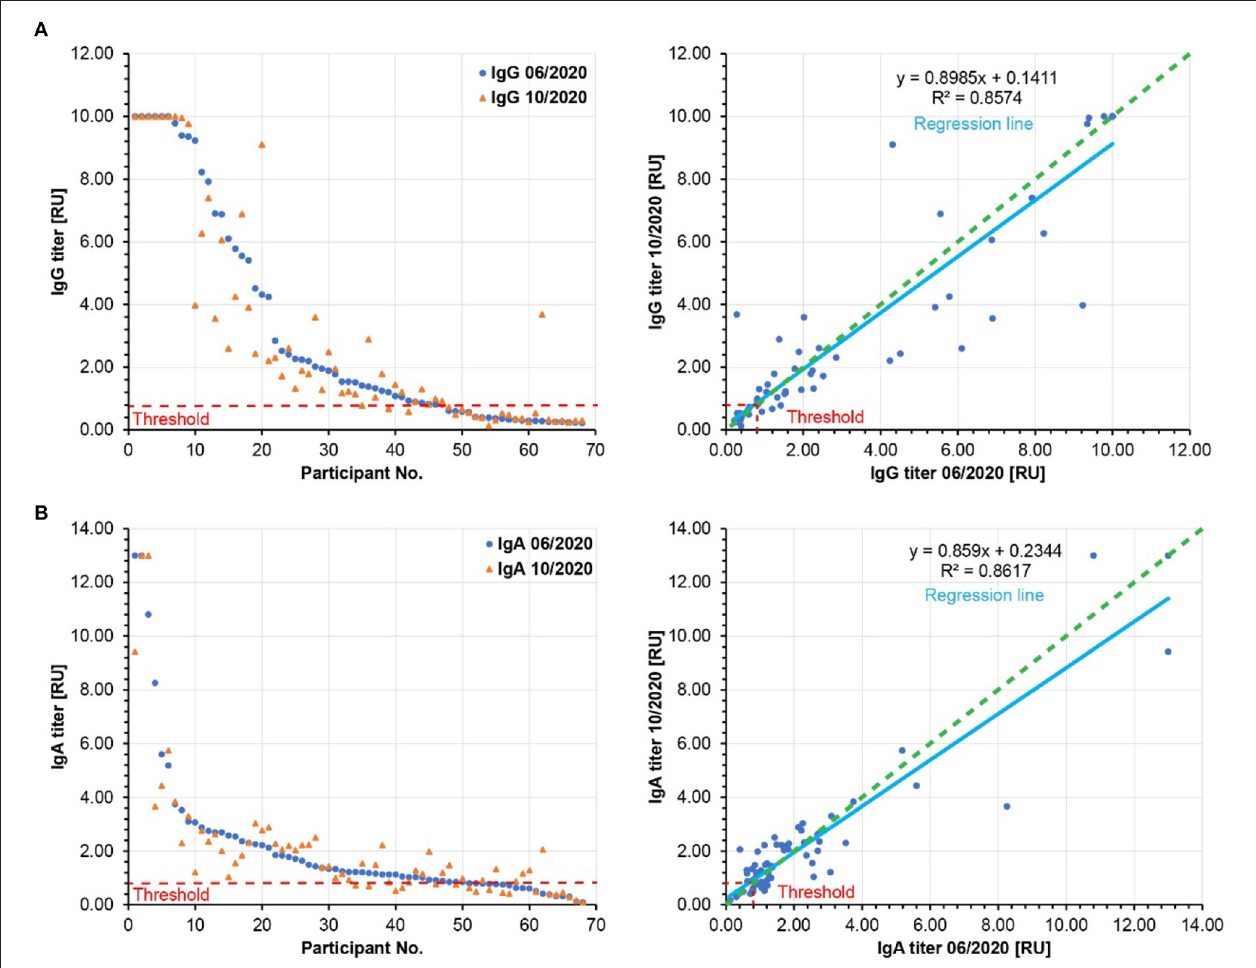
FIGURE 3 | Relative SARS-CoV-2 specific IgG (A) and IgA (B) antibody titers. Left panels: The participants are ordered according to decreasing relative antibody titers of the pilot study (blue, 06/2020). The respective relative antibody titers of the follow-up study (10/2020) were plotted in orange. Right panels: The relative antibody titers of the follow-up study (10/2020) are plotted against the relative antibody titers of the pilot study (06/2020). The slopes of the regression lines (light blue) are below 1.0, showing a moderate waning to the relative antibody titers by 10% for IgG and by 14% for IgA. Green dashed lines: hypothetical regression lines in the case of 100% antibody persistence. Red dashed lines: Threshold of significant antibody detection (0.8 for both IgG and IgA). Only the data of the 68 participants are shown here, whose sera were analyzed in both pilot and follow-up